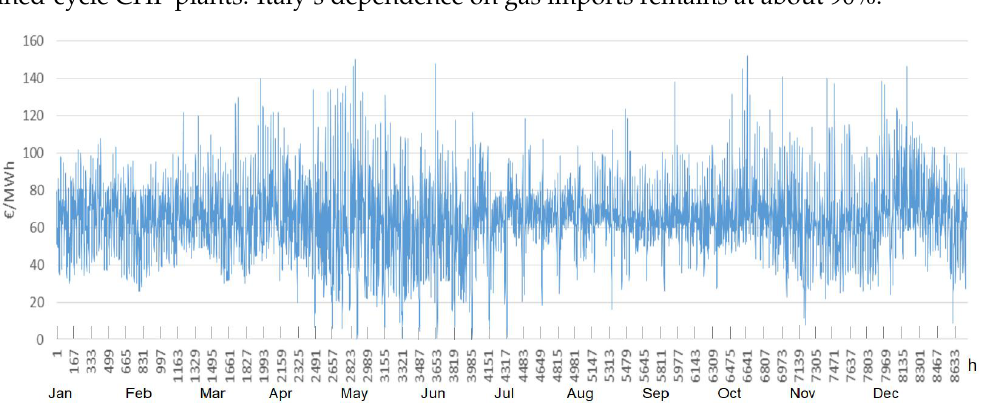
Figure 10. Market electricity price for Italy during the year 2013.